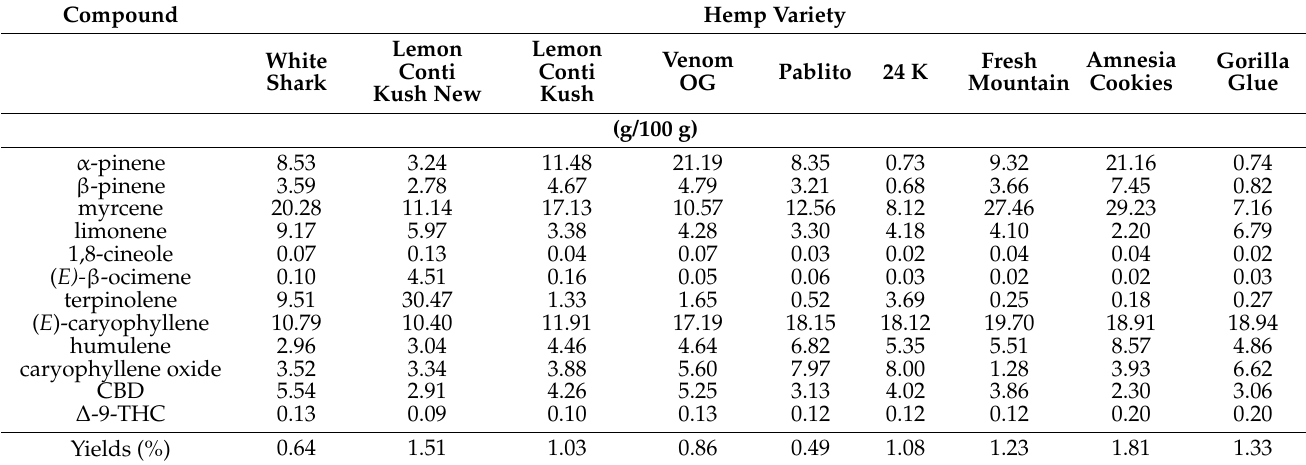
Table 1. GC-FID analysis results for the 9 commercial varieties’ EOs and their yield values